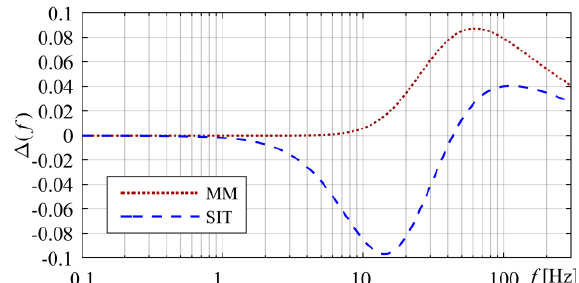
Fig. 5. MT2 model matching error.